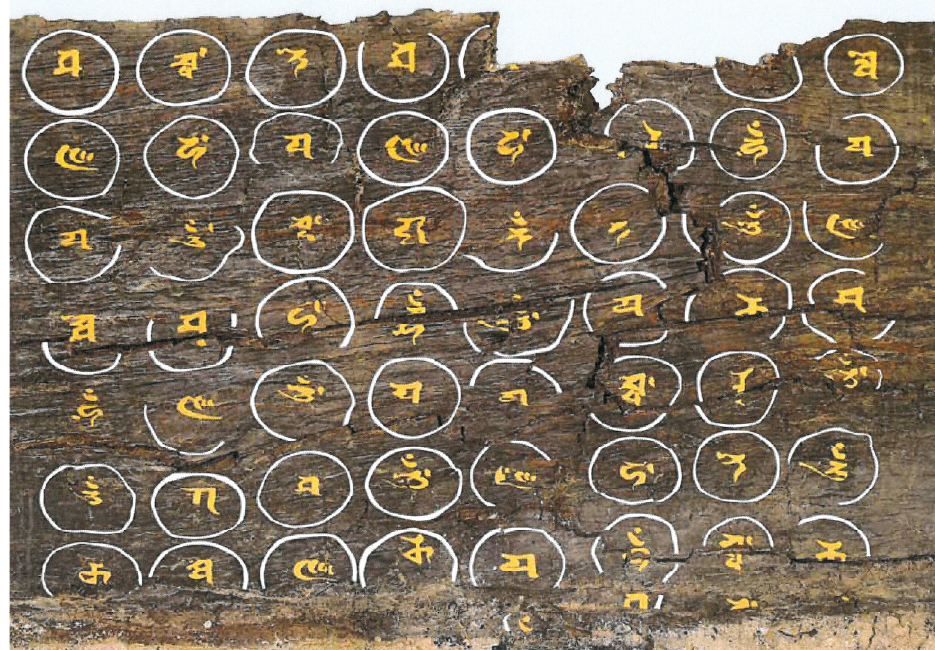
Figure 15. Reconstruction of Sanskrit letters on the west panel of the Nongso coffin. After (Kungnip Naju munhwajae yŏn’guso 2016, p. 111, Figure 54).